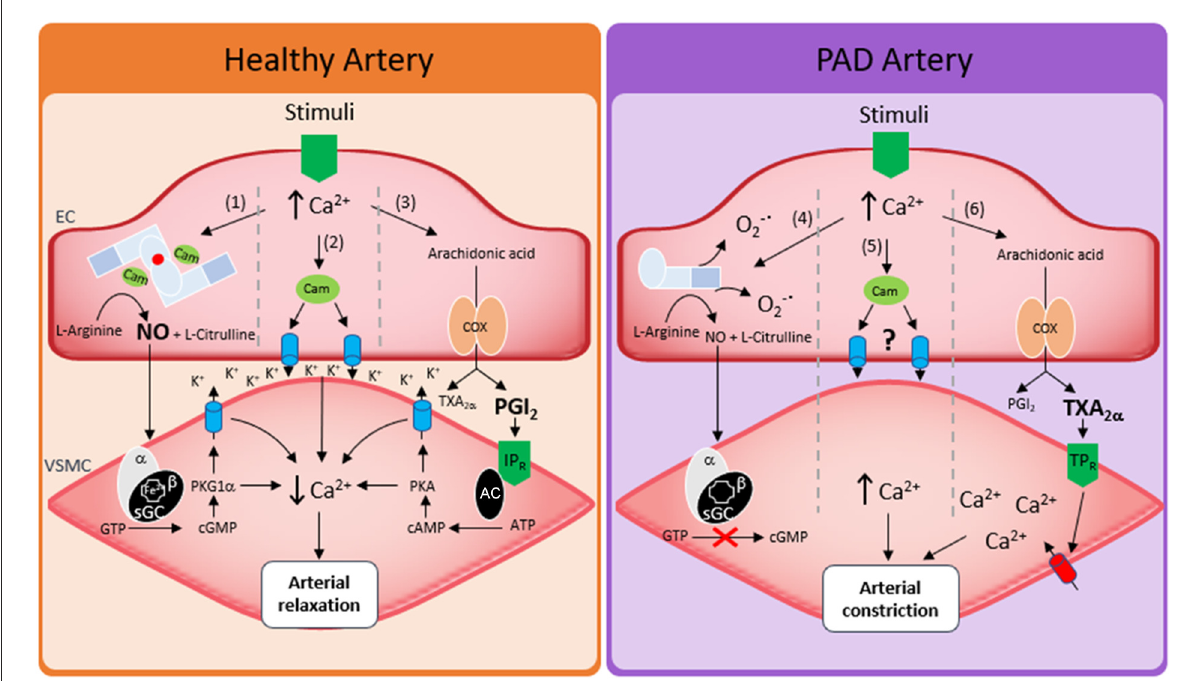
FIGURE2 Regulation of vessel tone in healthy arteries and in PAD. Left hand side shows three mechanisms of arterial relaxation in healthy arteries. (1) Nitric oxide induced arterial relaxation, endothelial calcium binds calmodulin which in turn facilitates eNOS mediated oxidation of L-Arginine forming NO and citrulline. NO then diffuses from the endothelial cell (EC) to the vascular smooth muscle cell (VSMC) where it activates soluble guanylate cyclase (sGC). sGC then converts guanosine triphosphate (GTP) into cyclic guanosine monophosphate (cGMP). cGMP activates protein kinase G1a (PKG1 α ) which lowers smooth muscle calcium through potassium channel mediated hyperpolarization of smooth muscle cells. (2) Increased endothelial calcium binds calmodulin which in turn activates small and intermediate conductance calcium activated potassium channels. Potassium efflux through these channels hyperpolarizes vascular smooth muscle via direct spreading of membrane potential or via activation of smooth muscle ion channels. (3) Endothelial calcium increases and increases arachidonic acid formation from membrane phospholipids. Arachidonic acid is the metabolized via cyclooxygenase 1 or 2 (COX) to form prostaglandins. The dominant prostaglandin formed is prostacyclin (PGI 2 ). PGI 2 then activates the IP receptor (IPR) which converts adenosine triphosphate (ATP) into cyclic adenosine monophosphate (cAMP) in an adenylyl cyclase (AC)-dependent manner, cAMP then activates protein kinase A (PKA) which lowers smooth muscle calcium through potassium channel mediated hyperpolarization of smooth muscle cells. Right hand side shows how peripheral